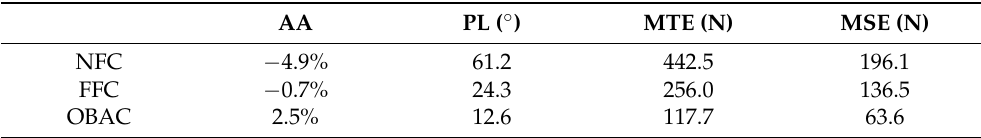
Table 5. Performance indexes for the dynamic loading experiment (different frequency operation for tested